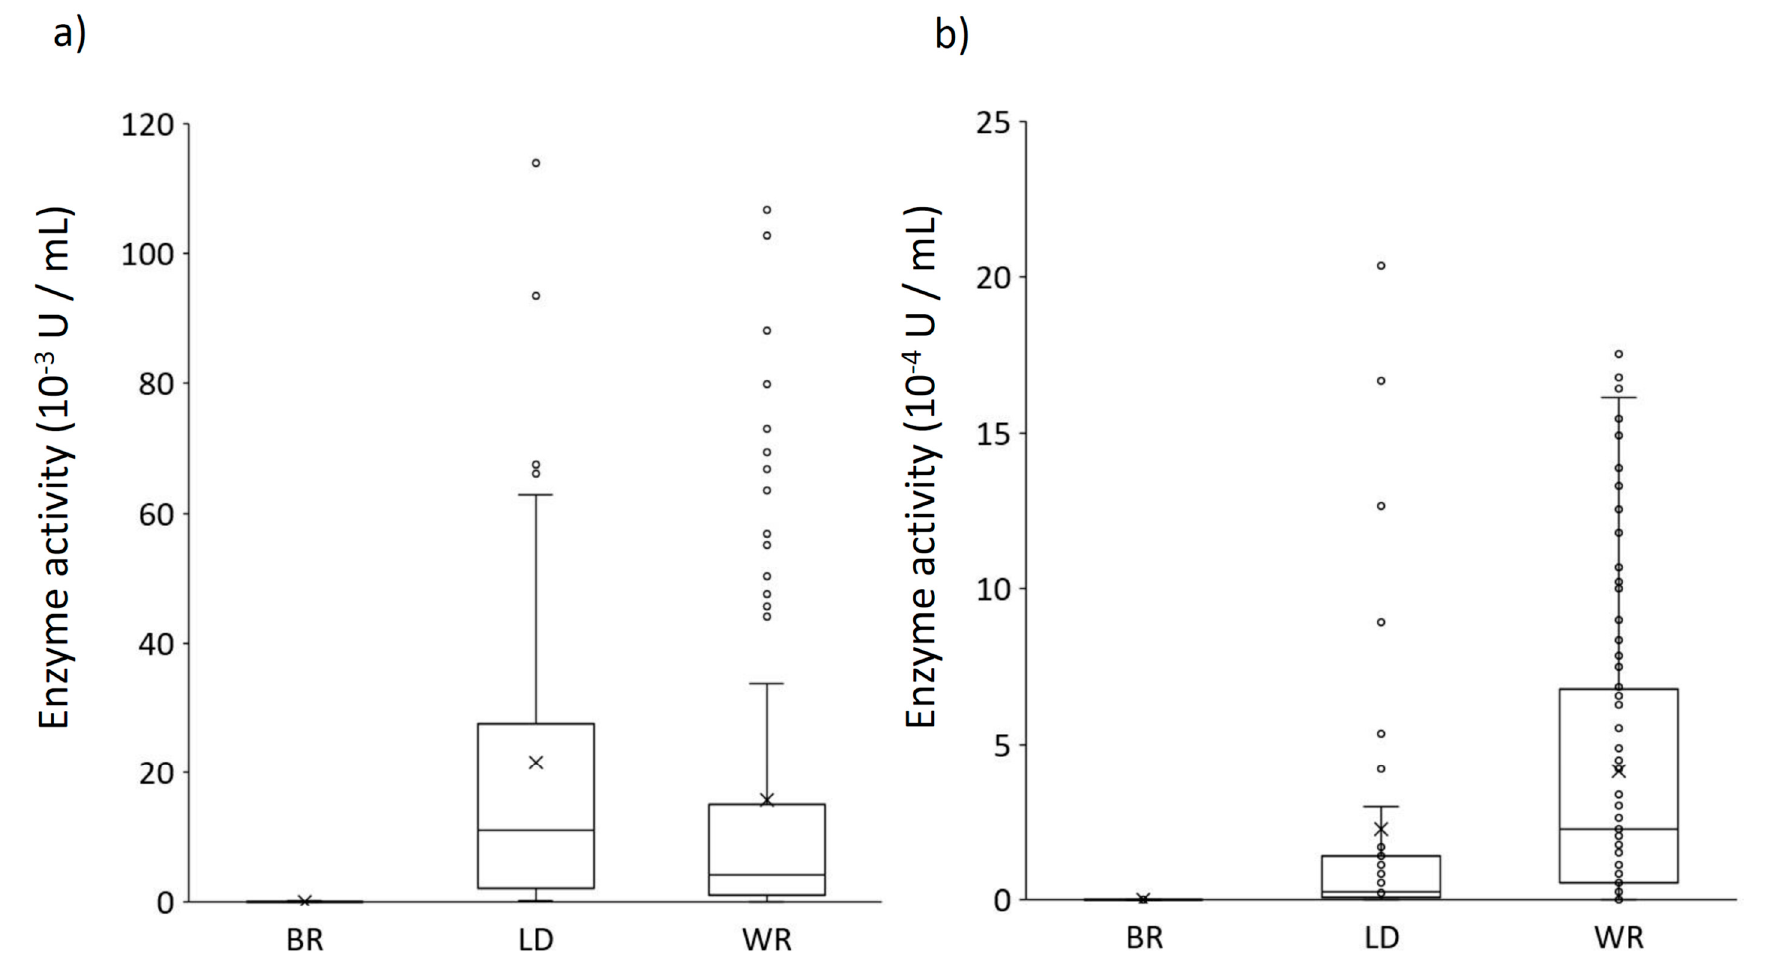
Figure 1. Distribution of peak activities of laccase ( a ) and Mn-peroxidase ( b ) in cultures of brown rot fungi (BR, n = 7), litter decomposing fungi (LD, n = 38), and white rot fungi (WR, n = 105). The box plots indicate upper and lower quartiles and means, while outlier values are represented as individual points.